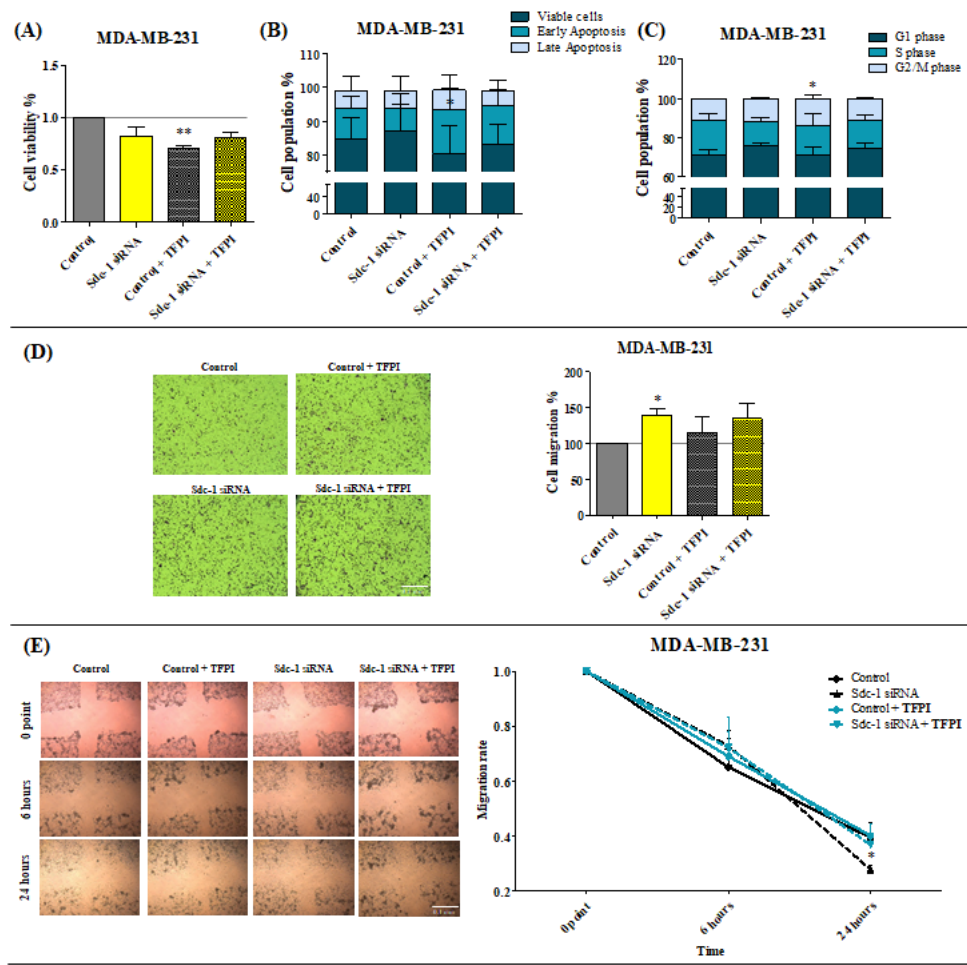
Figure 3. Treatment with TFPI decreases the viability and invasive phenotype of MDA-MB-231 cells. ( A ) The MTT assay revealed a significant effect of TFPI treatment on cell viability (n = 3). ( B ) Early apoptotic MDA-MB-231 cells were found to be increased with respect to TFPI (50 µ g/mL) treatment. Apoptosis was determined after Sdc-1-depletion (24 h) and 48 h after 50 µ g/mL of TFPI treatment with annexin V and PI staining and by means of flow cytometry, and the percentage of viable (annexin V − /PI − ), early apoptotic (annexin V+/PI − ), and late apoptotic (annexin V+/PI+) cells are plotted as a percentage of the cell population (n = 3, MDA-MB-231). ( C ) TFPI treatment promotes cell cycle progression in MDA-MB-231 cells. Cell cycle phase composition was measured by means of DAPI staining and flow cytometry after Sdc-1-depletion and 48 hours of 50 µ g/mL TFPI treatment (n = 3, MDA-MB-231). ( D , E ) Sdc-1-KD increased the migratory characteristics of MDA-MB-231 cells, as determined using transwell migration and wound-healing (scratch) assays. The left panel shows representative images of both assays (10 × magnification) and the right panel shows the percentage of cell migration for the migration assay and the rate of migration for the scratch assay. Scale bars = 100 µ m. Data represent mean ± SEM. Asterisks on the top of the bars indicate significant differences between the control and all the conditions. Lines over the bars indicate significant differences (* p < 0.05, ** p <